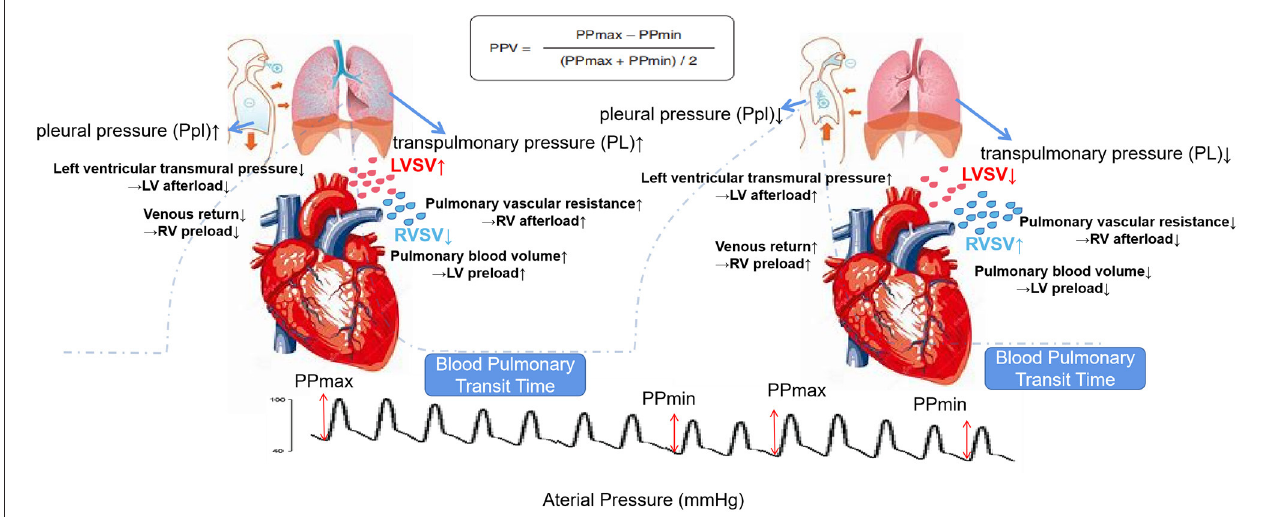
FIGURE 1 | Schematic effects of high transpulmonary pressure (P L ) and pleural pressure (P pl ) on the right ventricle (RV) vs. left ventricle (LV) to explain the mechanisms of pulse pressure variation (PPV). Blood pulmonary transit time means 2–4 heartbeat cycles for this blood flow effect conducting from the right heart to left heart. When exhaling, the effect of the drop in the stroke volume (SV) of the right heart during inhalation will affect the left heart. Top: calculation formula of PPV; background dotted line: airway pressure tracing; bottom: arterial pressure tracing. The left side is the inspiratory phase, and the right side is the expiratory phase.